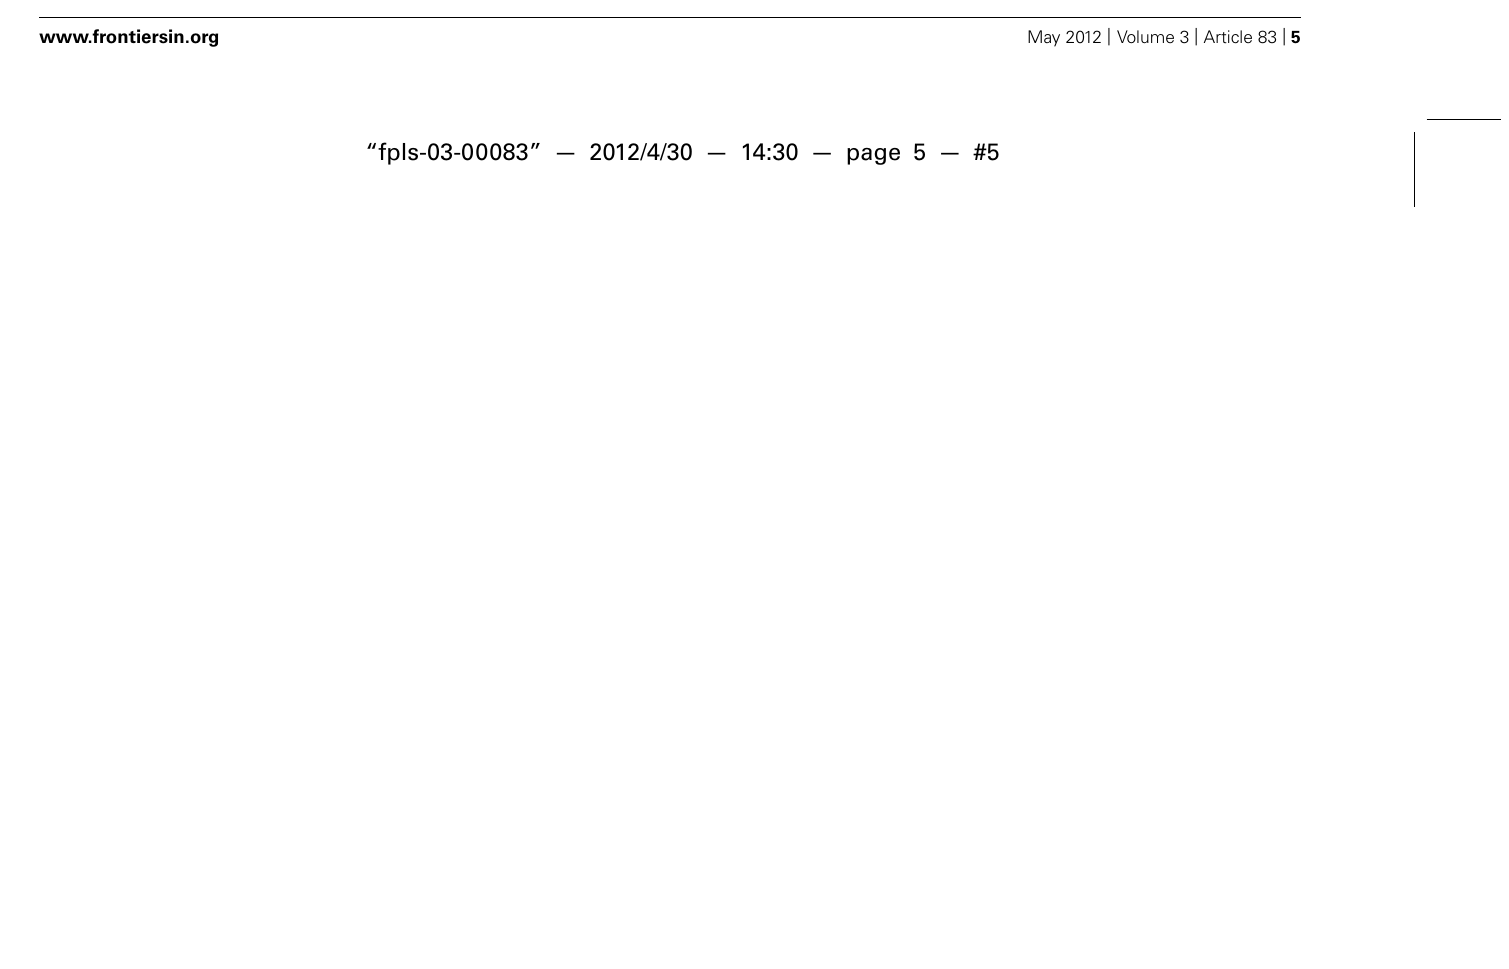
barley, Contig1805_s_at; poplar, PtpAffx.1672.3.A1_a_at; wheat, TaAffx.45277.1.S1_x_at. (B) Monolignol biosynthesis pathway (adopted from Boerjan etal., 2003). Arabidopsis genes present in the co-expression network of AtPAL1 were mapped on the pathway. Question marks indicate that the function of the respective genes has not been shown yet.The main routes for monolignol synthesis in dicots are highlighted in gray.